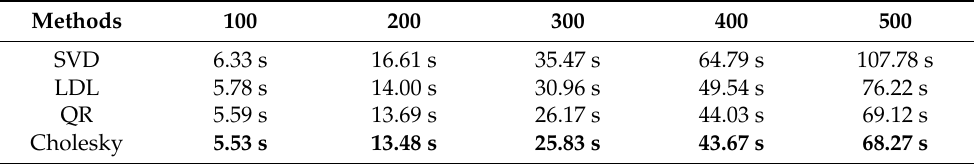
Table 6. Comparison of different decomposition